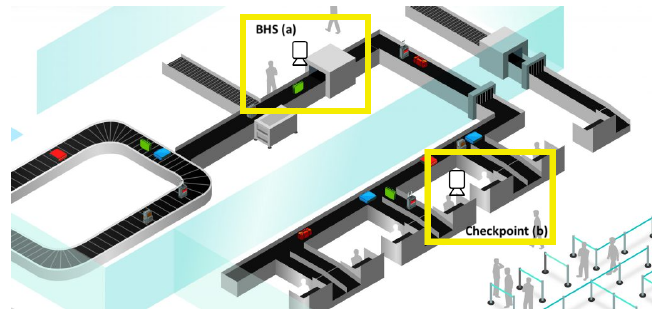
Figure 1. Multi-view camera system at: ( a ) Baggage Handling Systems (BHS), ( b )